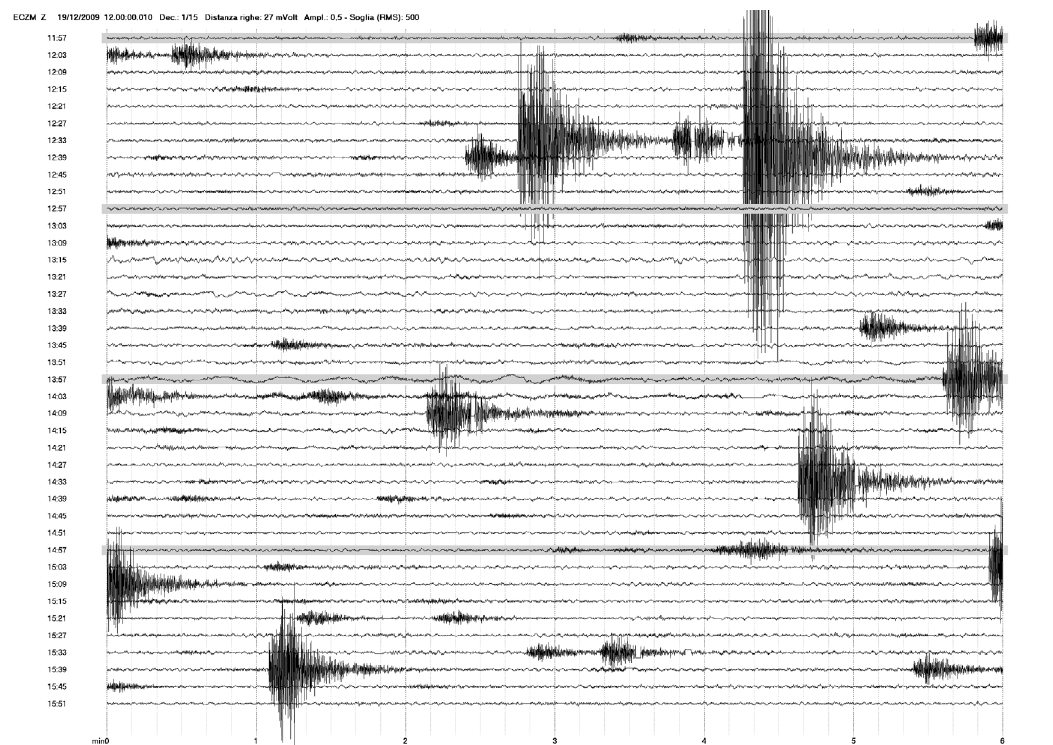
Figure 4. An example of bitmap that encompasses 4 hours of seismic signal, showing several earthquakes belonging to a seismic